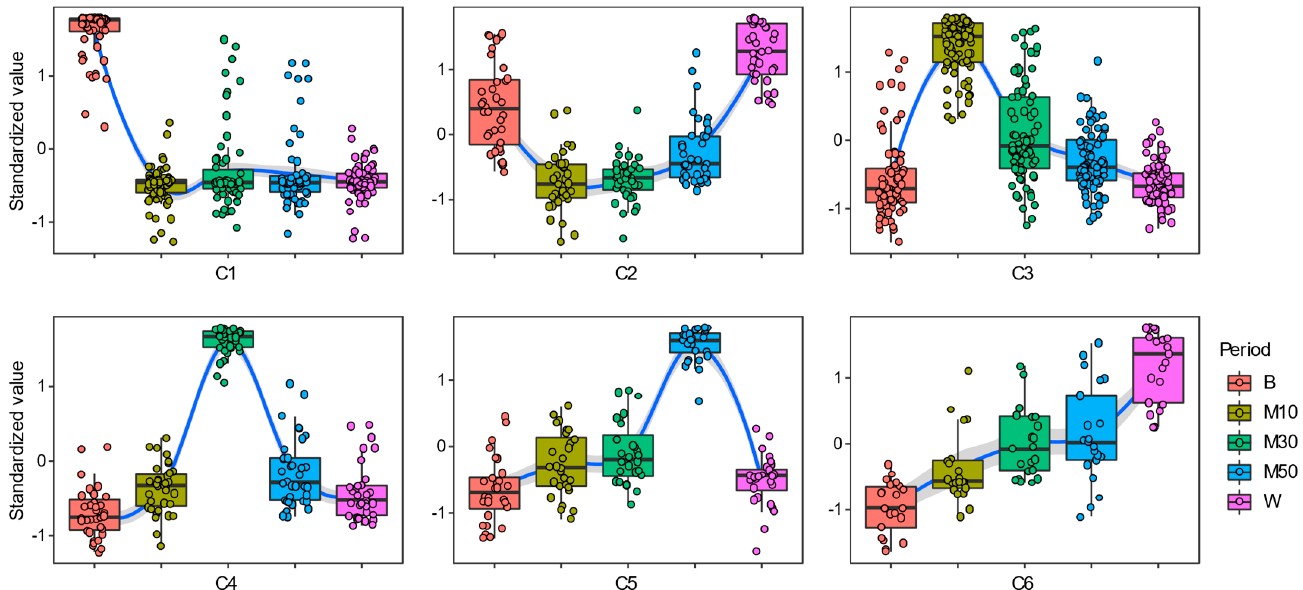
Figure 3. Six temporal dynamic patterns (C1-C6) of ruminal bacteria during the adaptation to monensin in goats. Note: B, baseline period; M10, M30, and M50, on d 10, 30, and 50 of the treatment period; W, washout period.